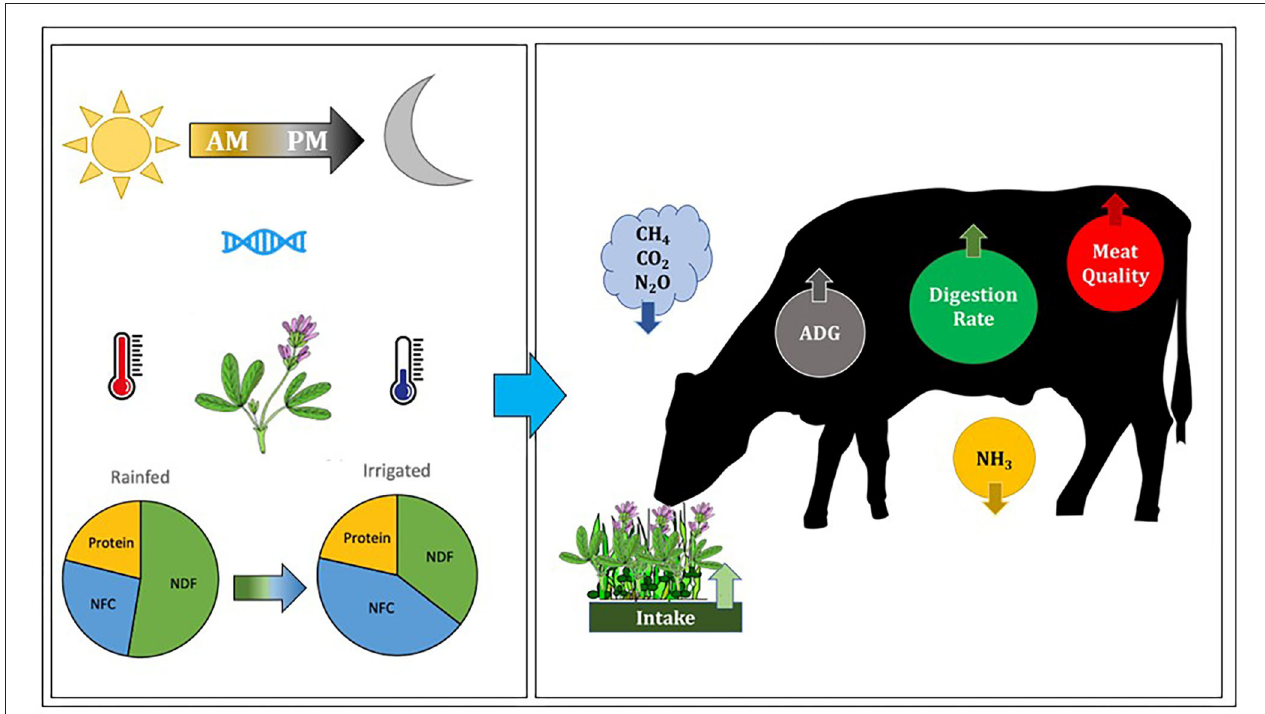
FIGURE 2 | Factors that increase the NFC of alfalfa and other perennial legumes include harvesting in the afternoon rather than the morning, breeding for greater pectin concentration, and greater photosynthesis combined with reduced aerobic respiration. Relatively dry climates in which forages are grown under irrigation are exposed to long hot sunny days with more solar radiation and therefore produce more photosynthate than more humid environments, and lower relative humidity results in cool nighttime temperatures that reduce aerobic respiration. The reduced fiber and increased NFC concentration of these forages result in more rapid digestion and emptying of the rumen, leading to greater intake, and increased ruminant production of meat and milk. Increased NFC also results in better protein utilization, increased nitrogen retention, less nitrogen excretion, and reduced enteric emissions of methane and carbon